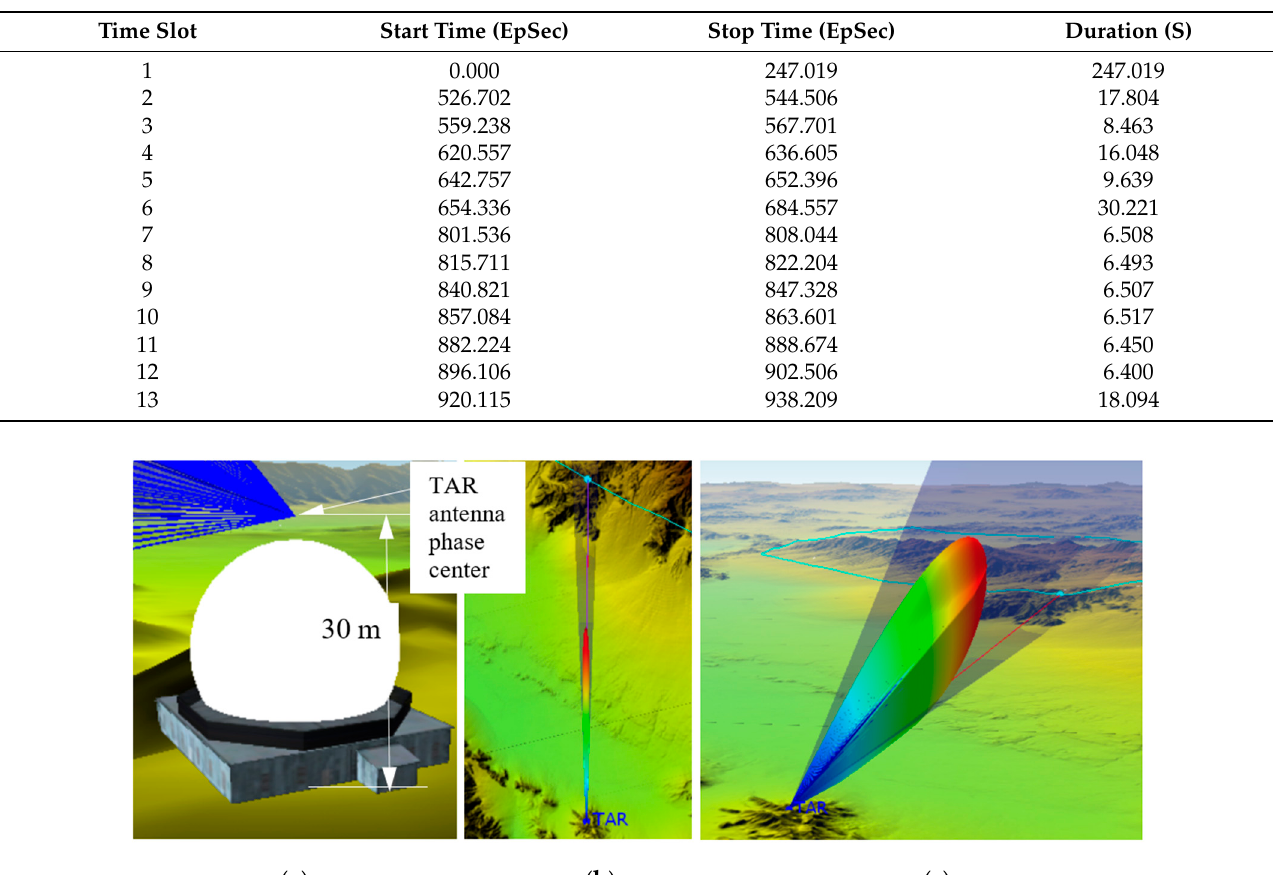
Table 3. Time slots (TS) that TAR inside RESM antenna 3dB beam with LOS.